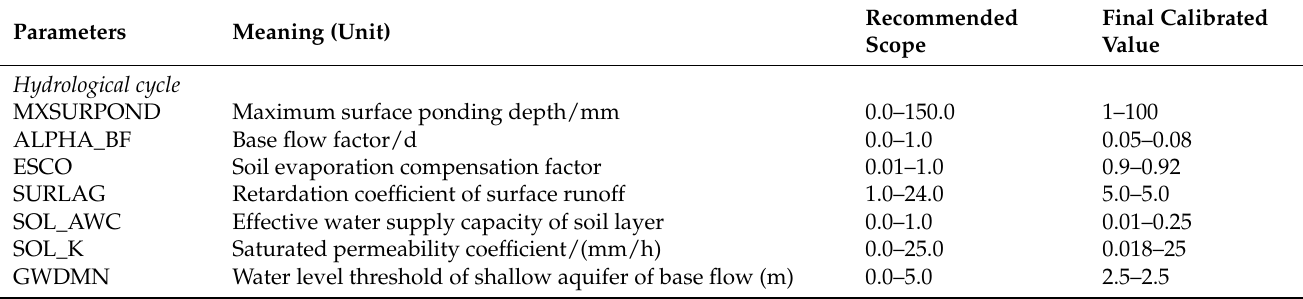
Table 2. Selection of key parameters for hydrological cycle and groundwater numerical simula- tion.